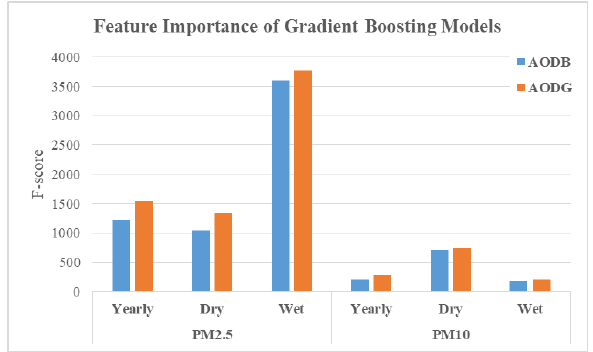
Figure 12. Feature importance of the generated gradient boosting models for PM estimation.